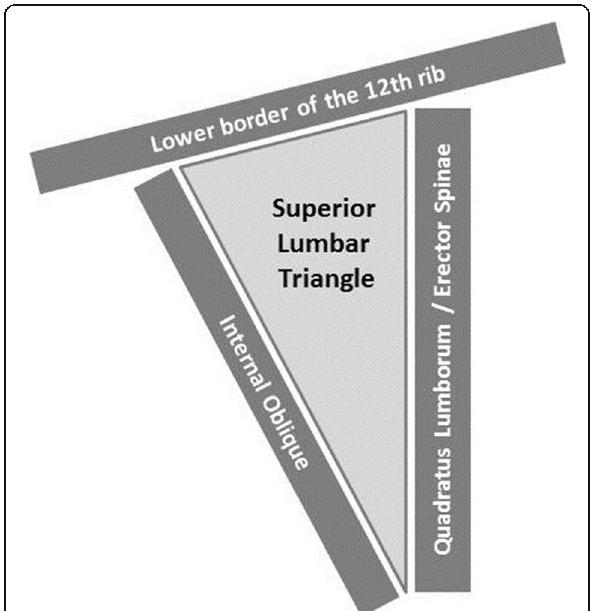
Fig. 3 Schematic display of the superior lumbar triangle. The triangle is inverted and partially covered by the latissimus dorsi. The base is formed by the lower border of the 12th rib the triangle is anteriorly bounded by the internal oblique muscle and posteriorly by the quadratus lumborum and erector spinae